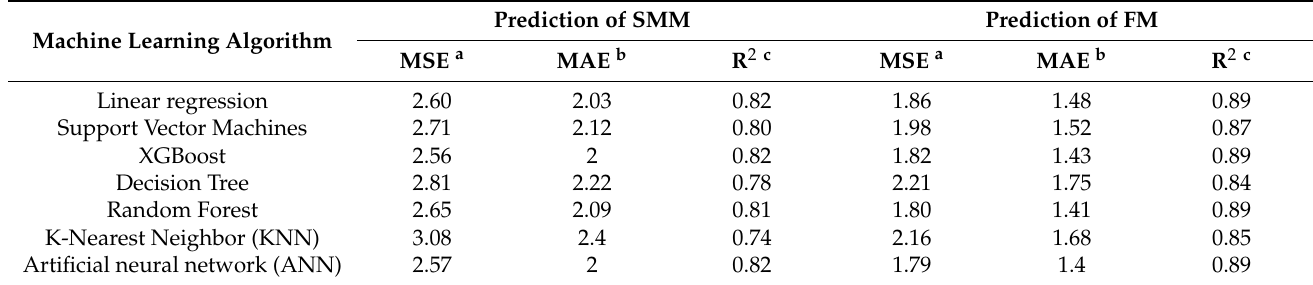
Table 2. Accuracy of prediction models using the test set of the Ansan/Ansung cohorts.